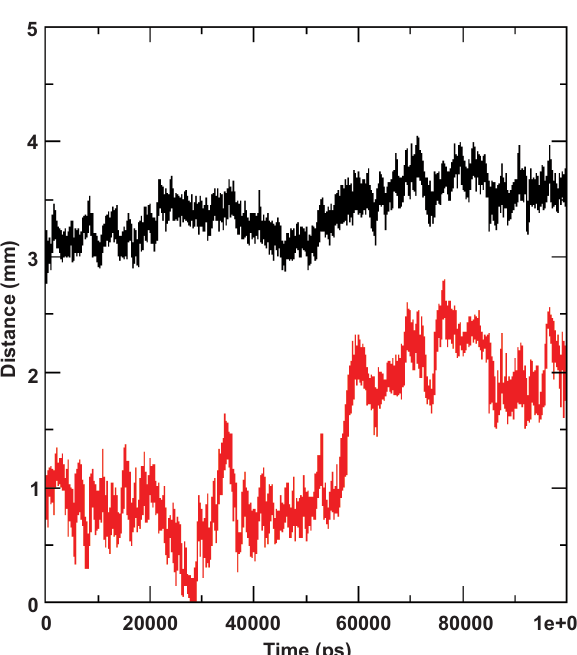
Figure 4. Distance between the helix (residues 689–703) and lipid leaflets during molecular dynamic simulation of the I-Tasser model. The distance to the upper lipid leaflet is plotted in red and lower leaflet is plotted in